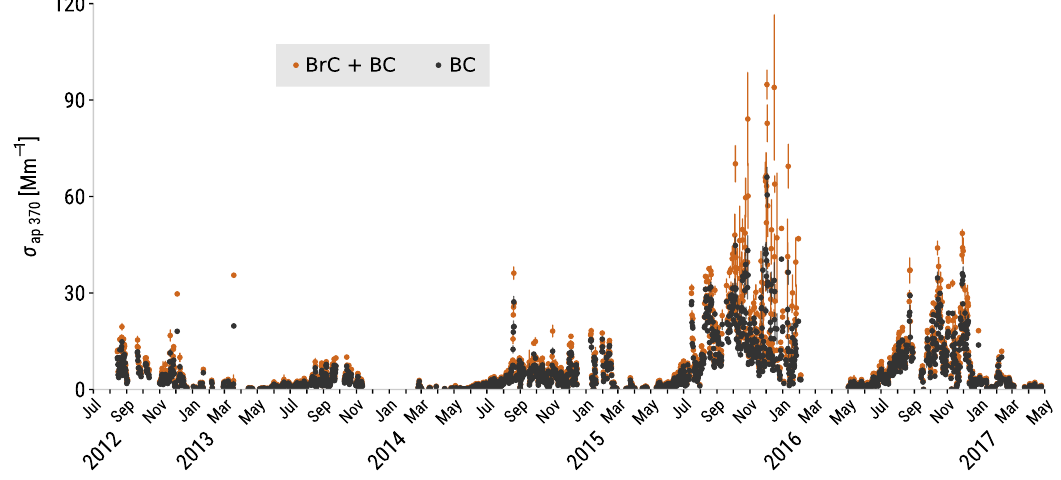
Figure 10. Total absorption at 370nm (12h average data) segregated by BC only (gray points) and BrC + BC (brown points). Error bars are equivalent to ± 1 standard error. Long-range transport dust events have been excluded from the analysis.